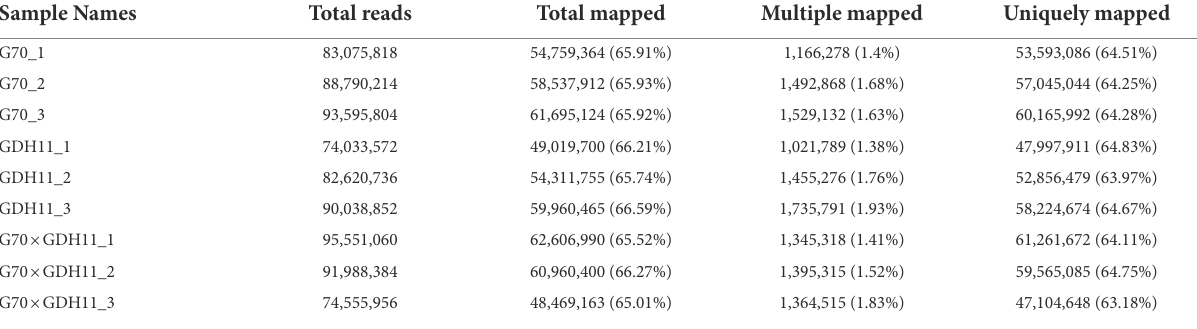
TABLE 2 Comparison results of root sequences on the reference